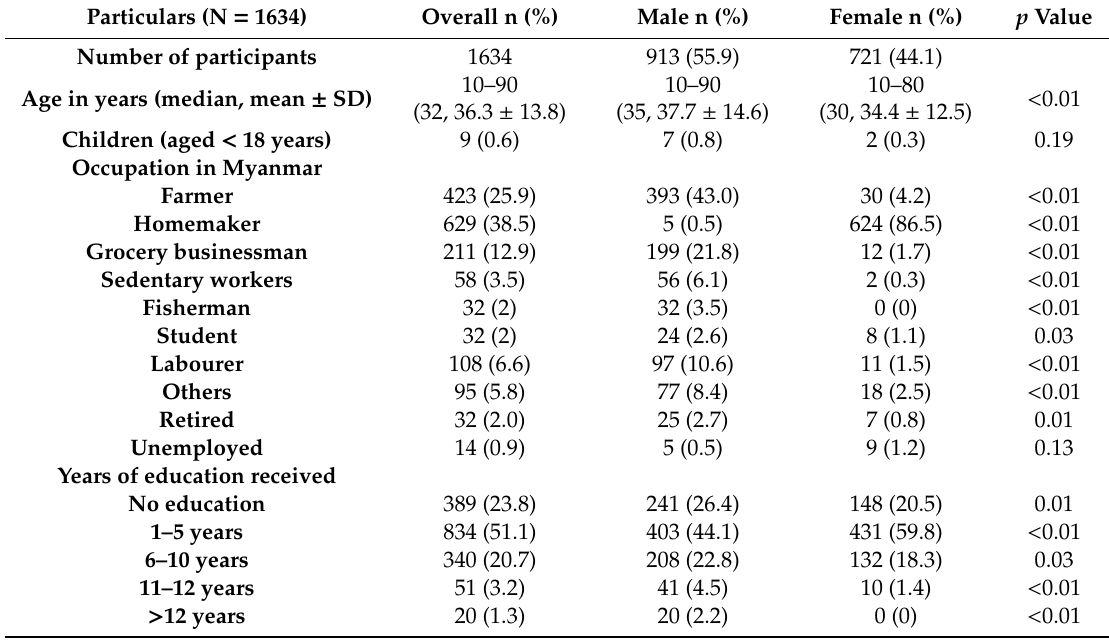
Table 1. Demographic characteristics of primary respondents among Rohingya refugees.